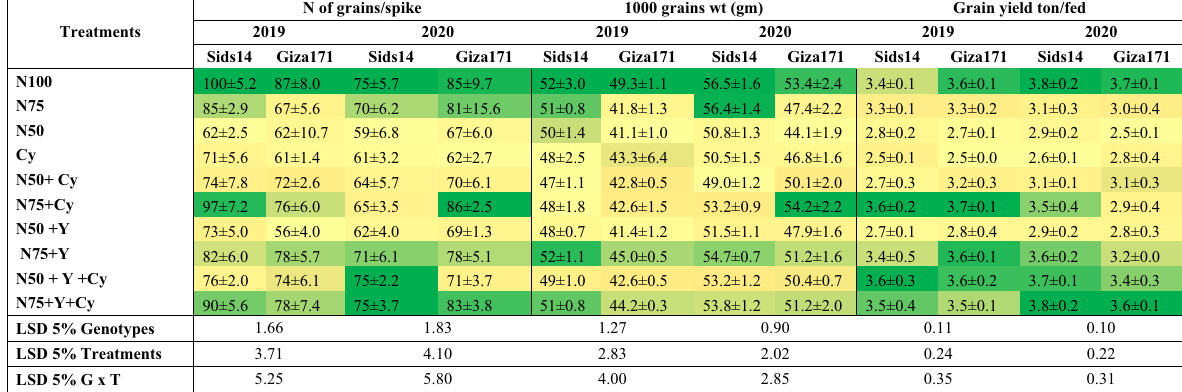
Table 5 Wheat yield componentsat the harvest (number of grains /spike, 1000 grains wt (gm) and grains yield (tonne/fed)). Wheat crop was treated with cyanobacteria (Cy), yeast (Y) and mineral fertilization (N; nitrogen dose) over two consecutive seasons (2019 and 2020). The color scale pattern was generated in Excel, lower values are denoted in yellow color, whereas higher values are depicted by a green color. Each value is mean of 3 independent replicates SE ±